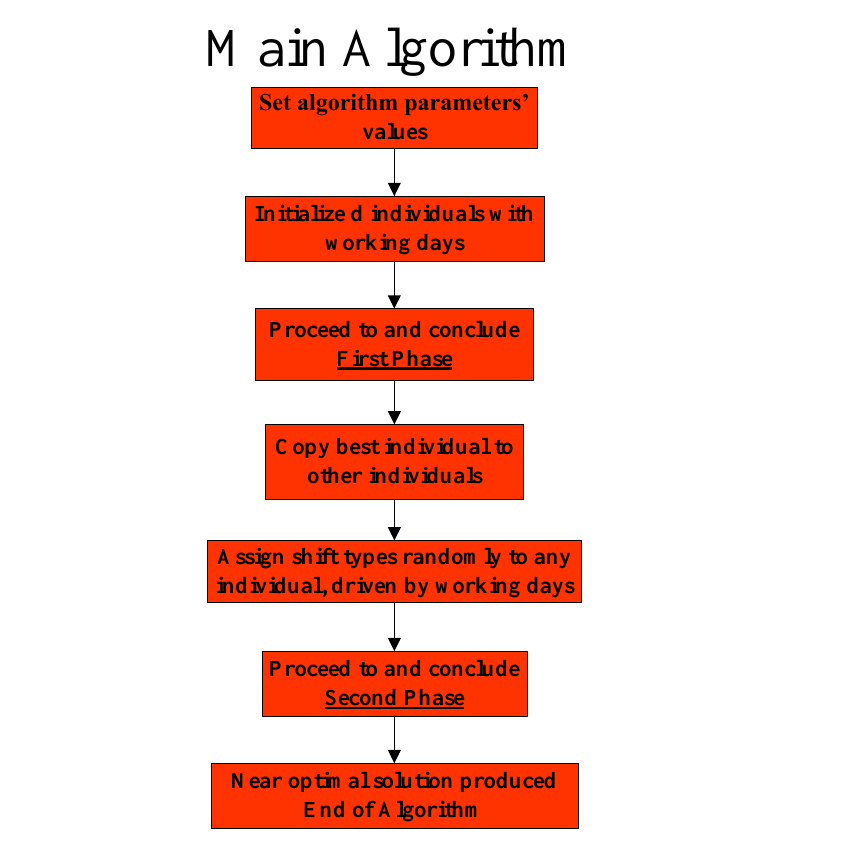
Figure 1. The structure of the proposed stochastic variable neighborhood search algorithm.